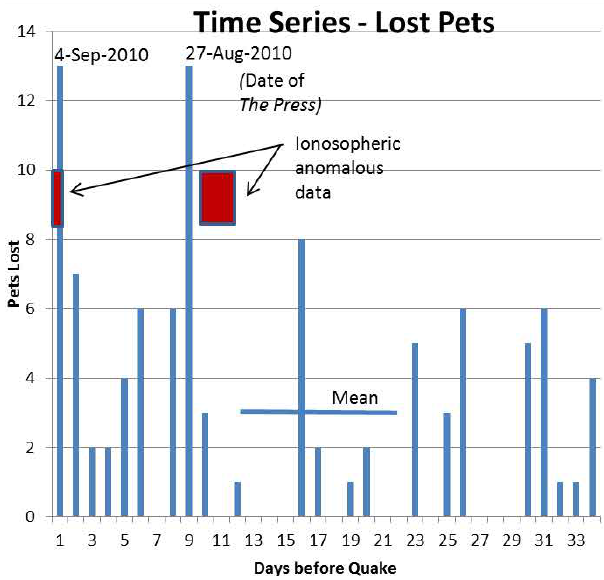
Fig. 4. Lost pet data for Christchurch, with ionospheric data su- perimposed (Yao et al., 2012). The data from The Press are from pets lost at least one day prior. Note there is a combined Satur- day/Sunday edition, therefore, every 7th day lacks a data point and the Monday reports could be double